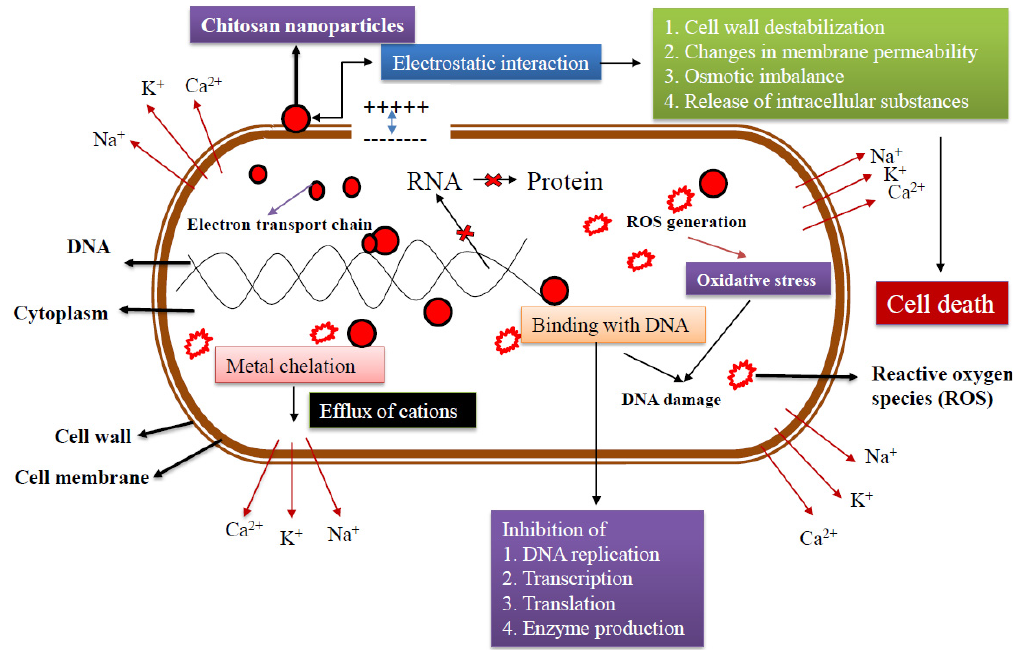
Figure 3. Antibacterial mechanisms of chitosan nanoparticles.